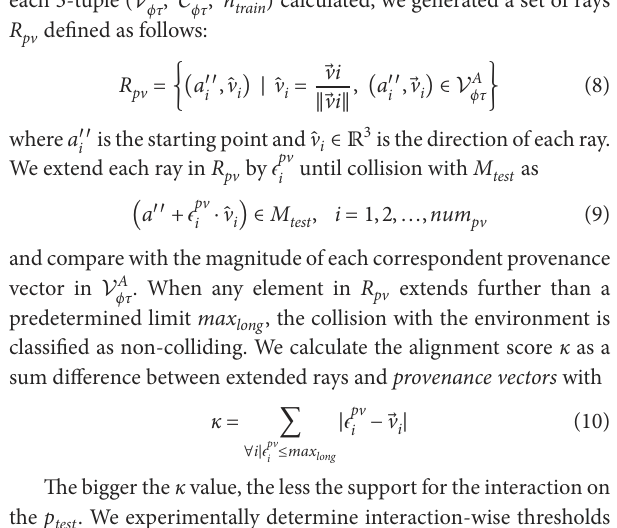
ρ as the decision threshold for the angle difference. ρ ⃗ n based on the level of mesh